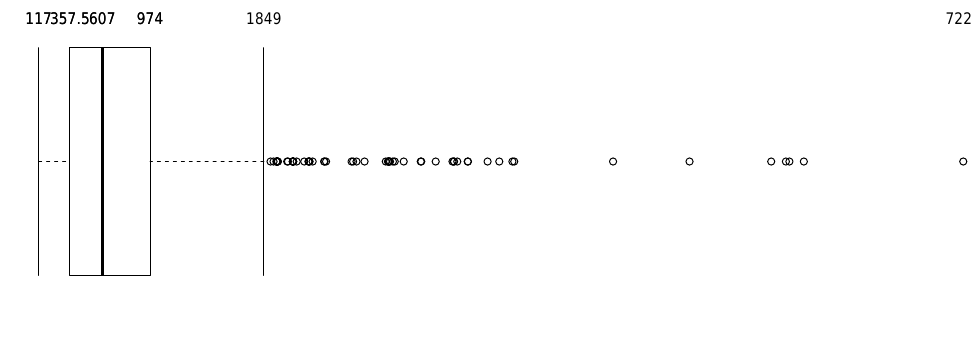
117357.5607 974 7227